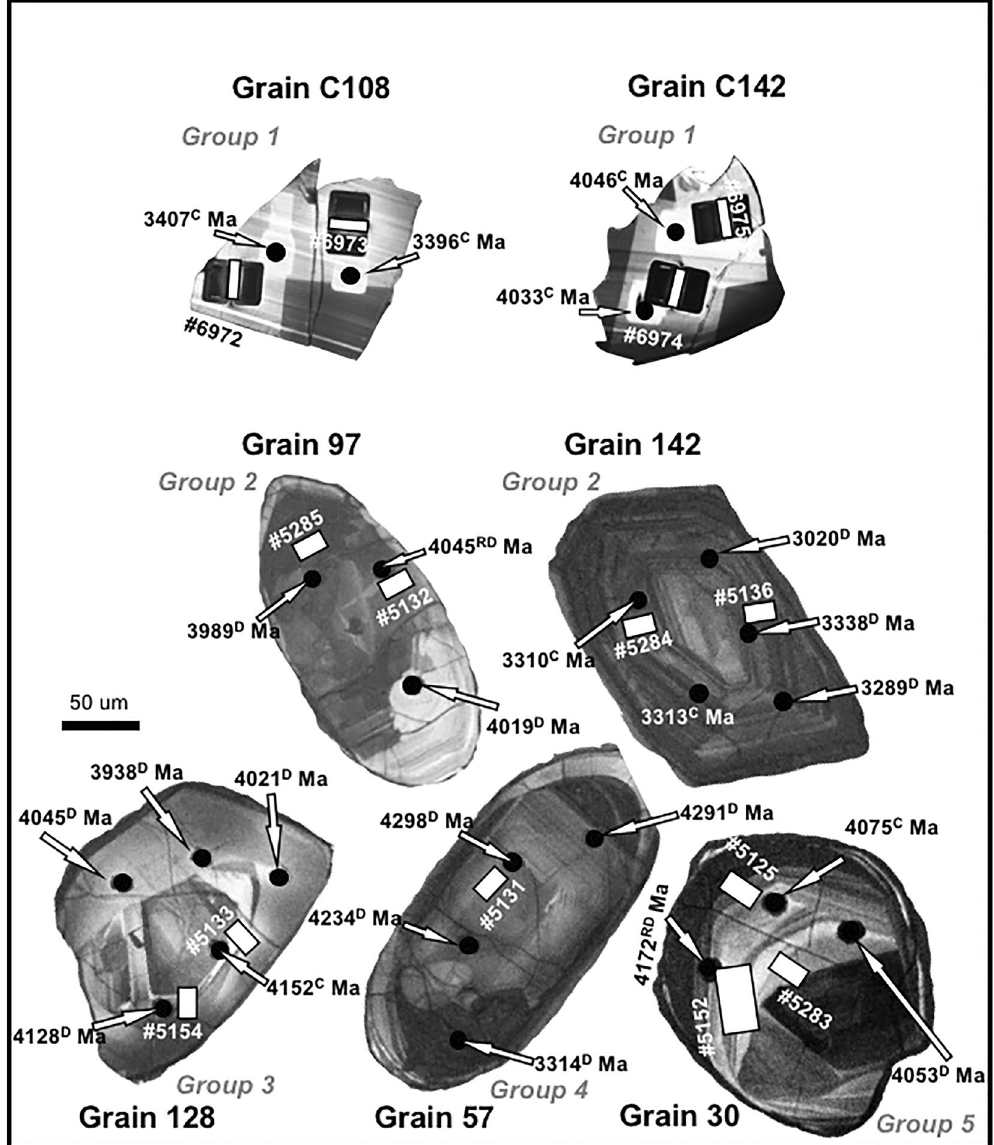
Figure 1. Cathodoluminescence (CL) images of Jack Hills detrital zircon grains from the W74 site used in this study. They are identified by grain and group number (see Table 1 and reference 29 for further details). Also shown are the U–Pb ages in million years (Ma) of the SIMS sites (black spots) and where the FIB foils were cut (the latter shown as white rectangles, with foil identifying numbers). The letters in superscript after the U–Pb ages are: C concordant, D discordant, RD reversely discordant. Grains C108 and C142 from Group 1 show additional damage around the FIB sites compared to the other images because they were taken post-TEM